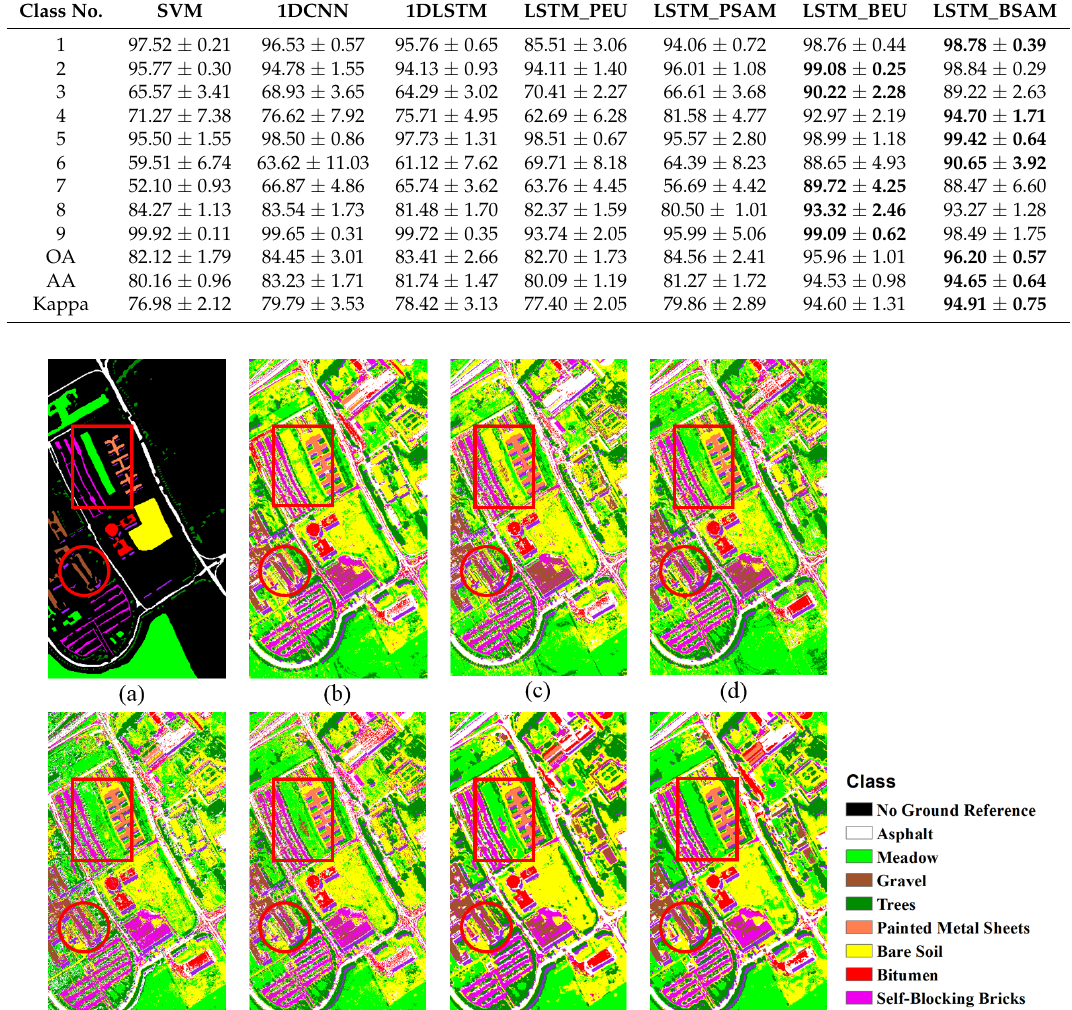
Table 3. Comparison of different classification accuracy results for the Pavia University image (%),